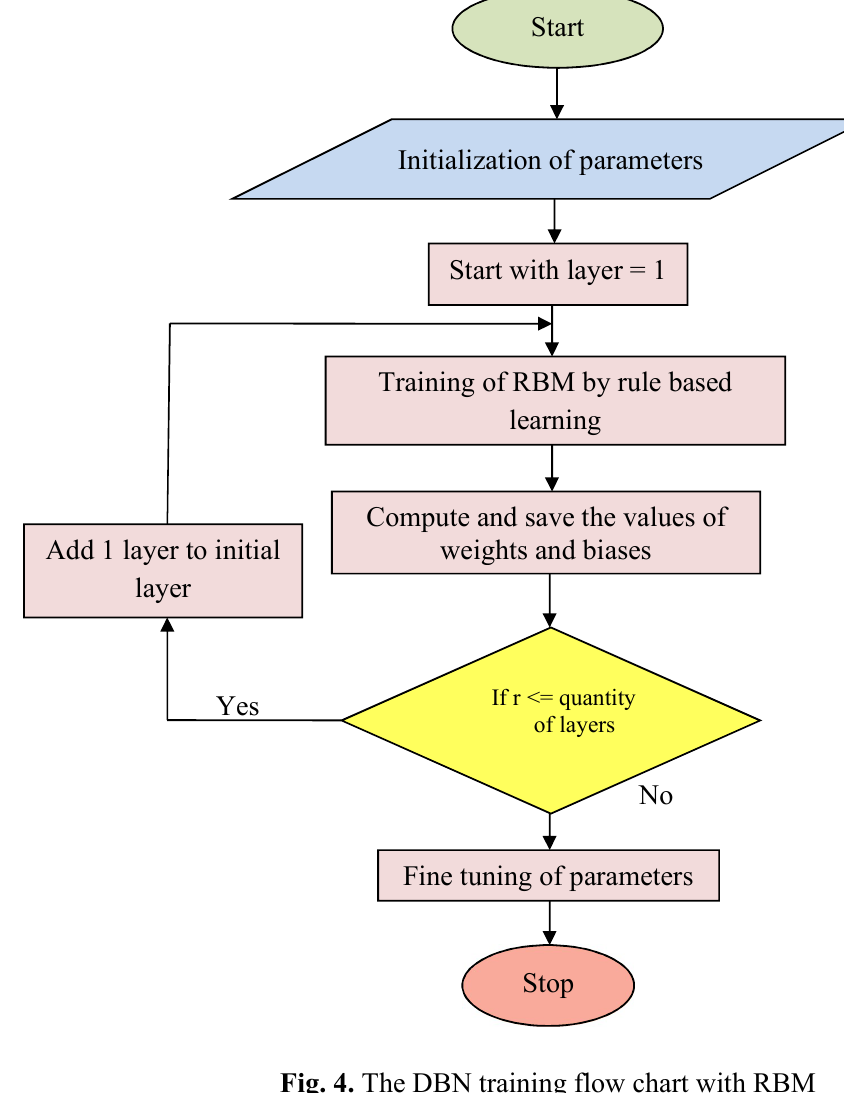
Fig. 4. The DBN training flow chart with